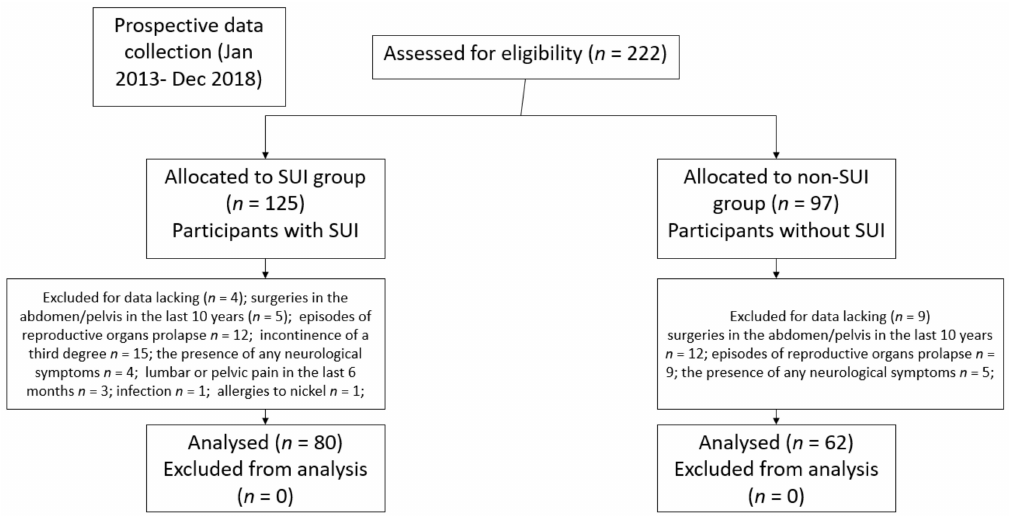
Figure 1. Flowchart showing the recruitment of participants (postmenopausal women, n = 220). Table 1. Comparison of the demographic and clinical characteristics of participants between the two